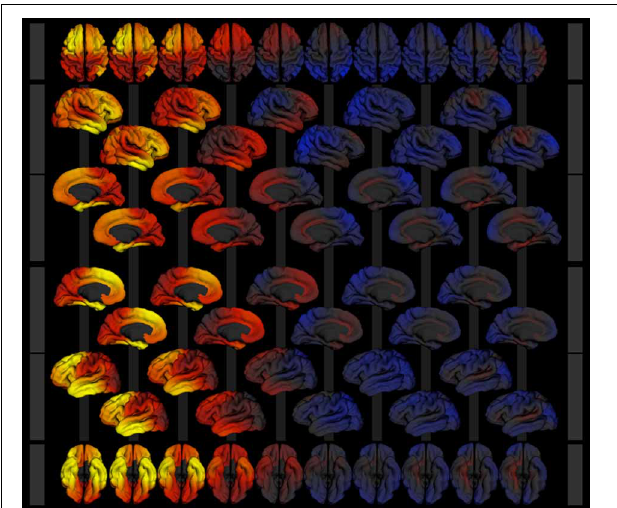
FIGURE 8 | Image collage of surface models exported from the surface viewer application for the model described in section 3. Cortical area expansion factor is mapped as color (red—expansion, blue—contraction) over age (3–21 years, left to right) given the model described in section 3. Rows show superior (1), right lateral (2 and 3), medial view of the right hemisphere (4 and 5), medial view of the left hemisphere (6 and 7), left lateral (8 and 9), and inferior (10) views of the 3d surface